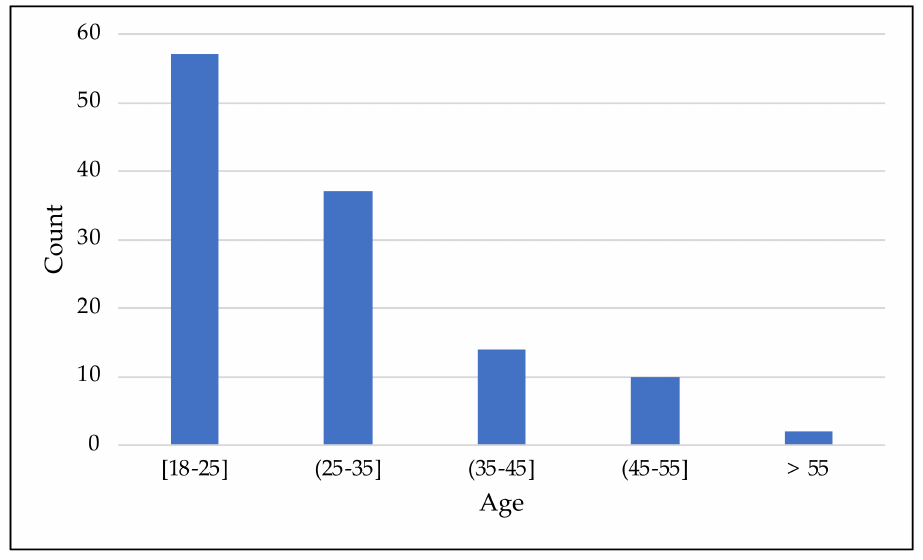
Figure 4. Number of respondents to the survey by